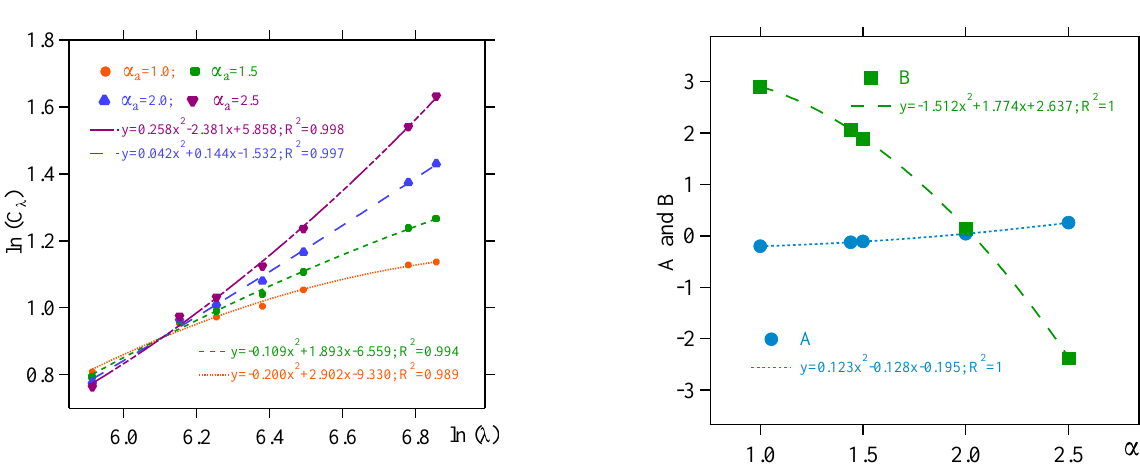
Figure 2. Variations of the coefficients A and B with α a